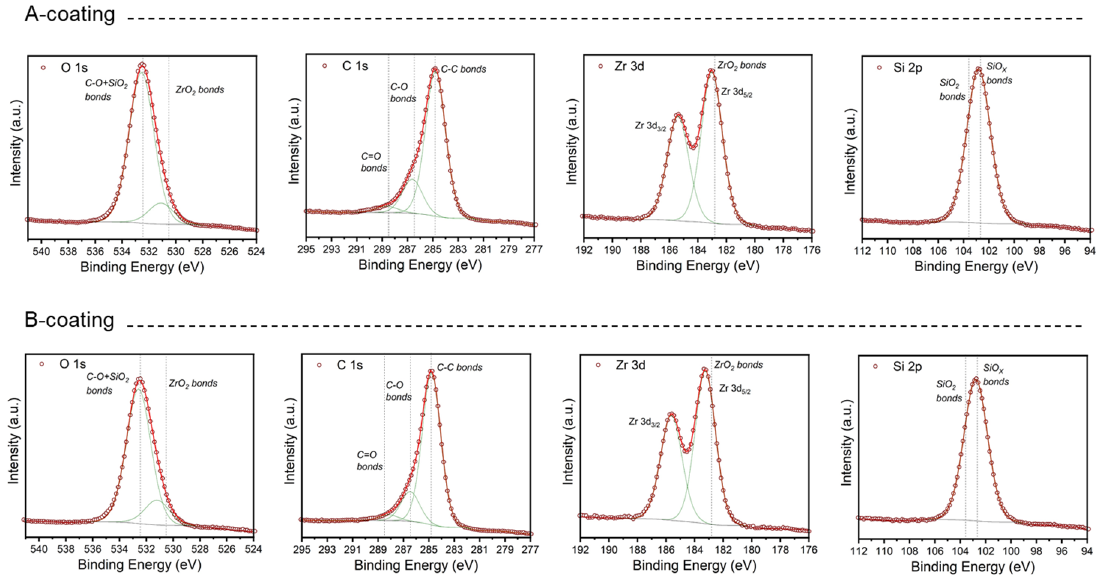
Figure 5. High-resolution XPS spectra of A- and B-coating materials.